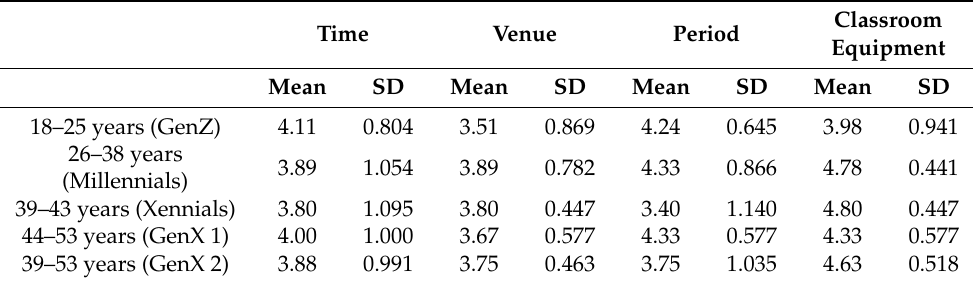
Table 9. Mean values and standard deviations of “spatial technical/logistical infrastructure” ques- tions in relation to age groups (generational cohorts) of budding journalists.